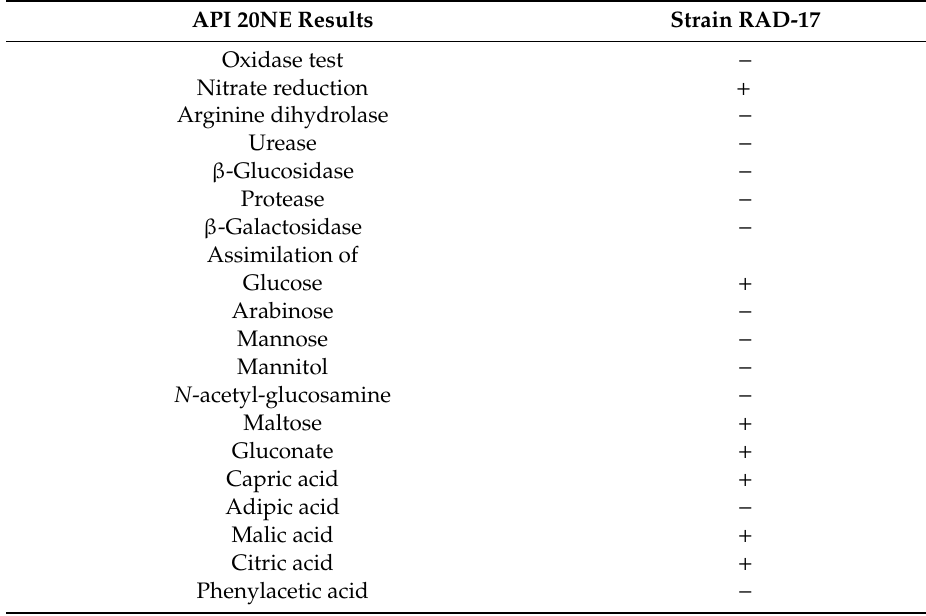
Table 2. of the RAD-17 strain determined by analytical profile index of Gram-negative with non- Enterobacteriaceae (API 20NE) tests.